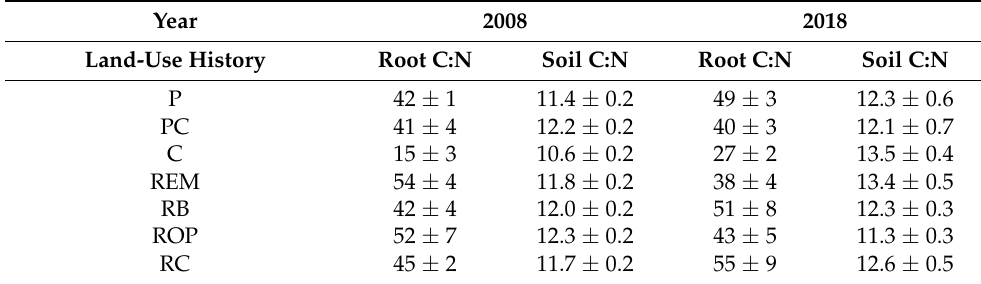
Table 3. Means and S.E.M.s of root and soil C:N ratios for land-use histories in 2008 and 2018. Land-use histories are cow pasture (P), cow pasture converted from row crop (PC), row crop fields (C), remnant prairie (REM), bison prairie restored from P and PC pastures (RB), prairie restored from old pasture (ROP), and prairie restored from row crop (RC). Year 2008 2018 Land-Use History Root C:N Soil C:N Root C:N Soil C:N P 42 ± 1 PC